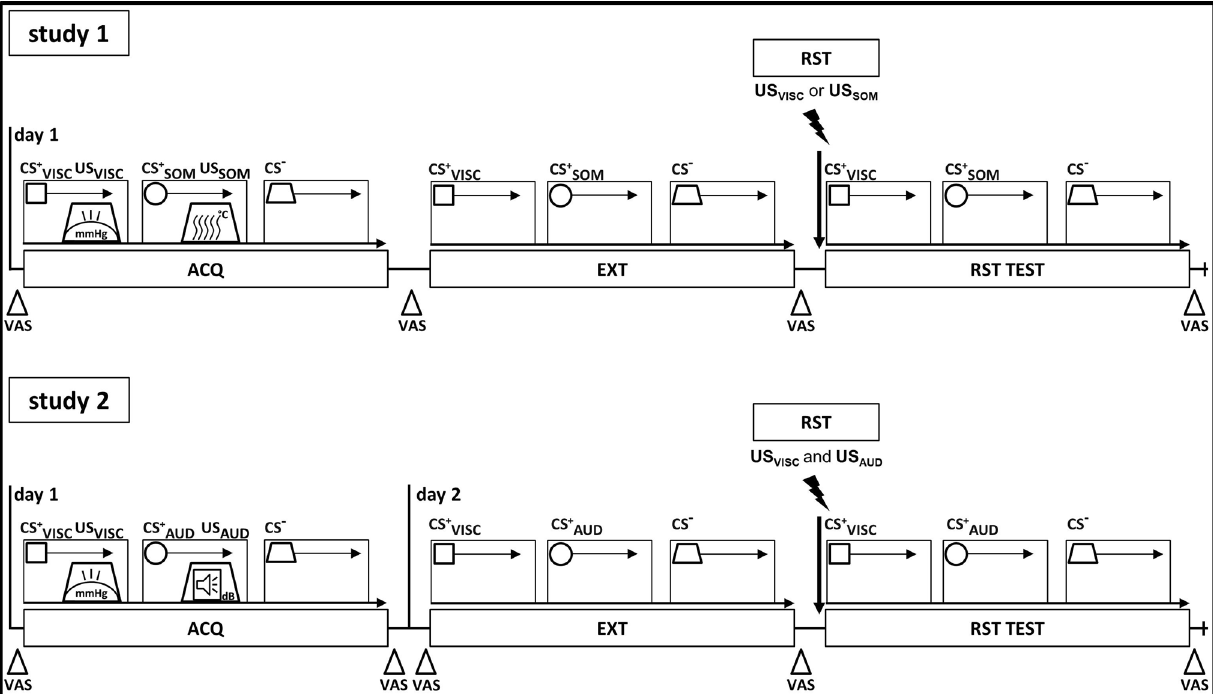
Fig. 4 Schematic overview of study designs. All participants in studies 1 and 2 underwent acquisition (ACQ), extinction (EXT), and reinstatement-test (RST-TEST) phases. As for unconditioned stimuli (US), visceral pain (US VISC ) and either equally painful somatic pain (study 1, US SOM ), or equally- unpleasant auditory stimuli (study 2, US AUD ) were implemented during acquisition (ACQ) and reinstatement (RST). As conditioned stimuli (CS), distinct visual geometrical symbols were paired with US (CS + VISC ; CS + SOM ; CS + AUD ) or were presented without US (CS − ) during acquisition (differential delay conditioning). All CS were presented without US during EXT and RST-TEST. RST procedures involved unsignalled US from one modality ( ‘ single threat reinstatement ’ in study 1: US VISC in one subgroup; US SOM in another subgroup) or from both modalities (multiple threat reinstatement in study 2: US VISC and US AUD in all participants). During all phases, functional magnetic resonance imaging (fMRI) was accomplished to assess shared and differential CS- and US-induced neural activation in regions of interest. Before and after each phase, behavioural measures were acquired with visual analogue scales